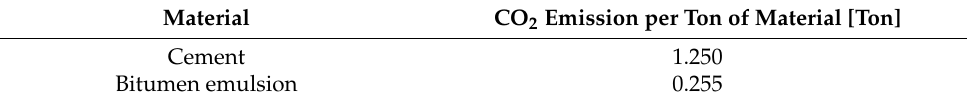
Table 10. Unit CO 2 emission.